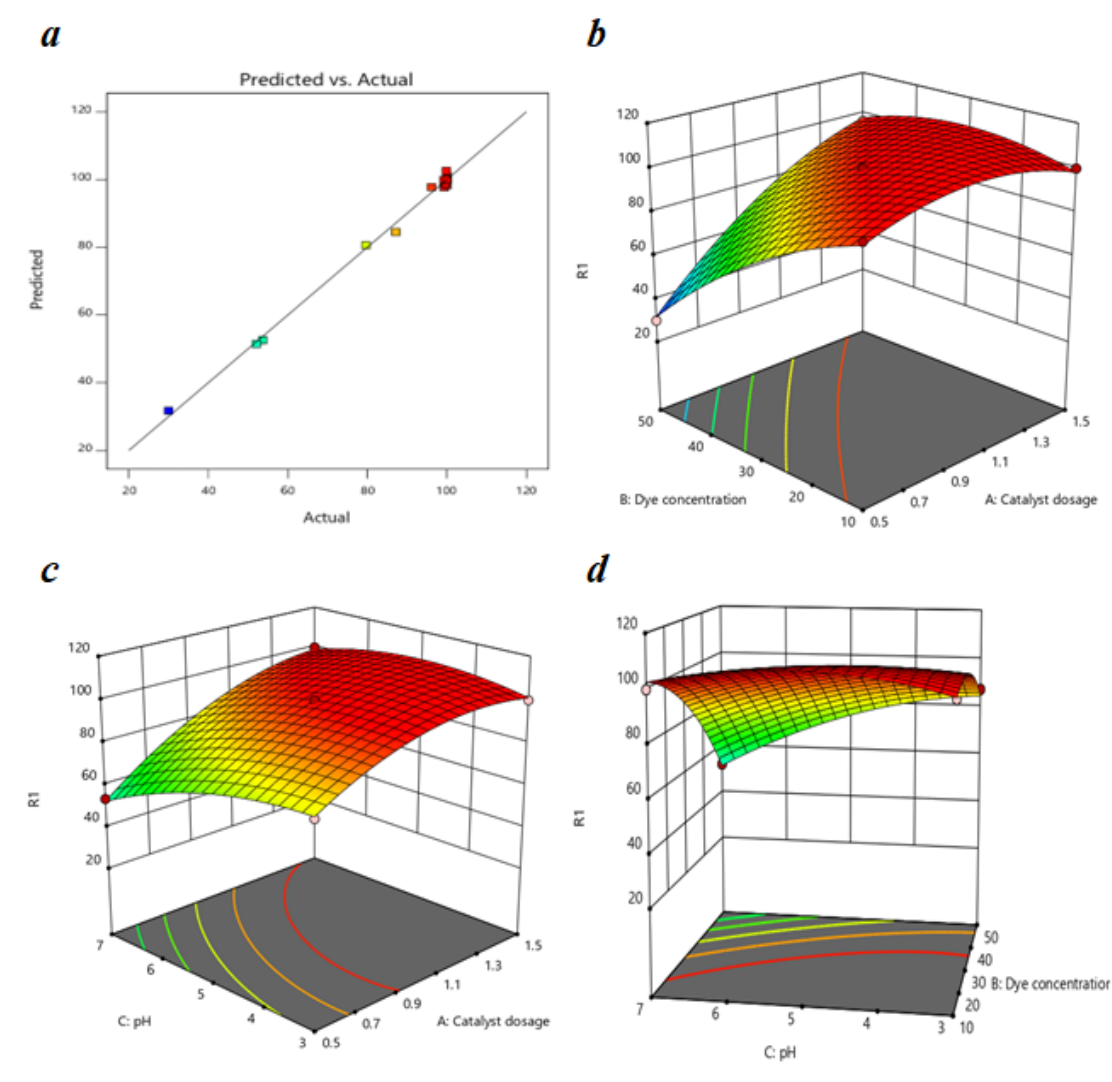
Figure 10. ( a ) A plot of predicted versus actual efficiency for MO removal (%); response surface graphs of MO removal as a function of ( b ) dye concentration and catalyst dosage, ( c ) pH and catalyst dosage, and ( d ) pH and dye concentration respectively.